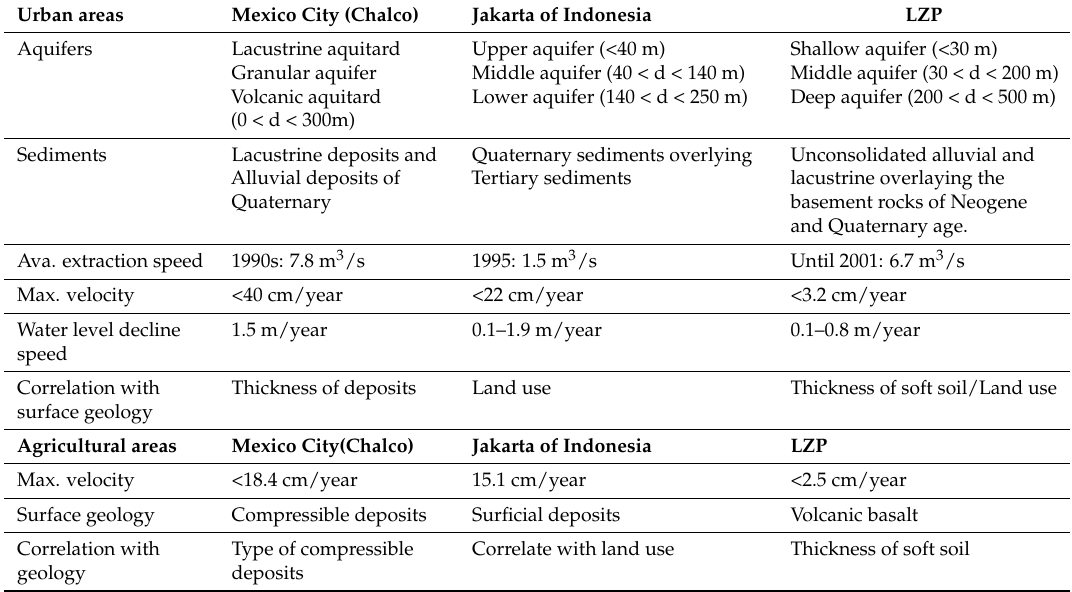
Table 3. Comparison of subsidence parameters in Mexico City [8,40,42], Jakarta of Indonesia [10,41], and the Leizhou Peninsula (LZP)